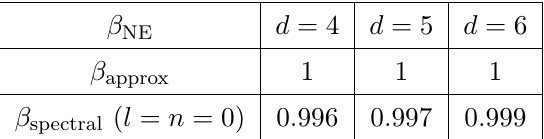
Table 3 . Comparison of (cid:12) approx derived from (3.3) versus (cid:12) spectral obtained with a spectral method for a d -dimensional RNdS BH with M = 1, (cid:3) = 0 : 1 and Q=Q max = 0 :